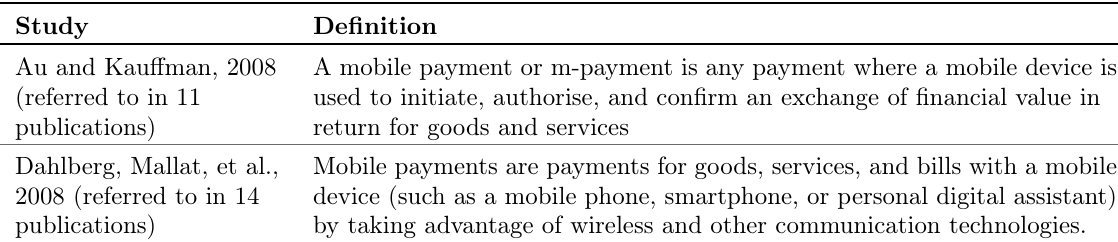
Table 6. The most commonly used definitions of mobile payments.